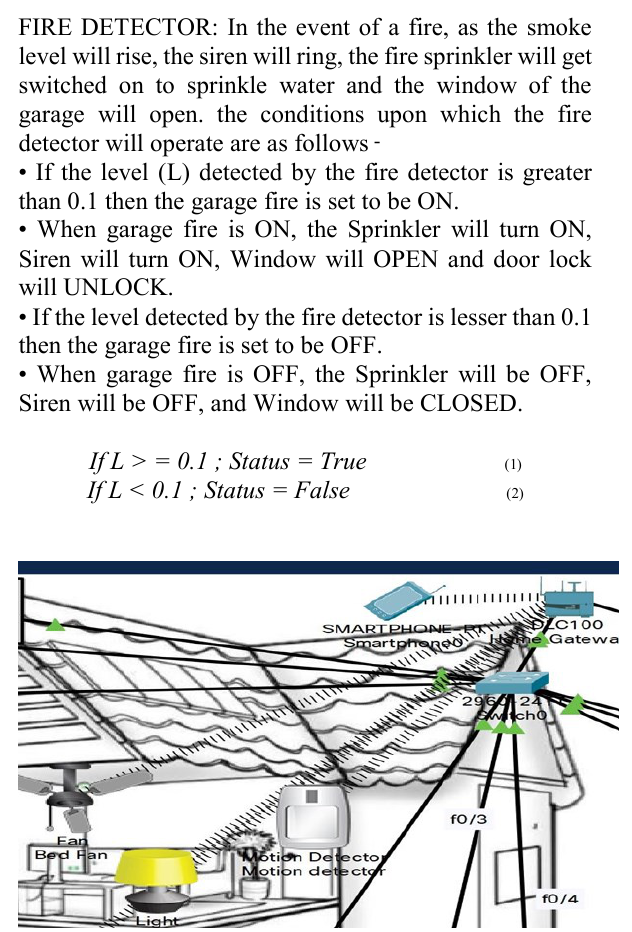
Fig. 3. Depicts the connection of the devices with the Home Gateway